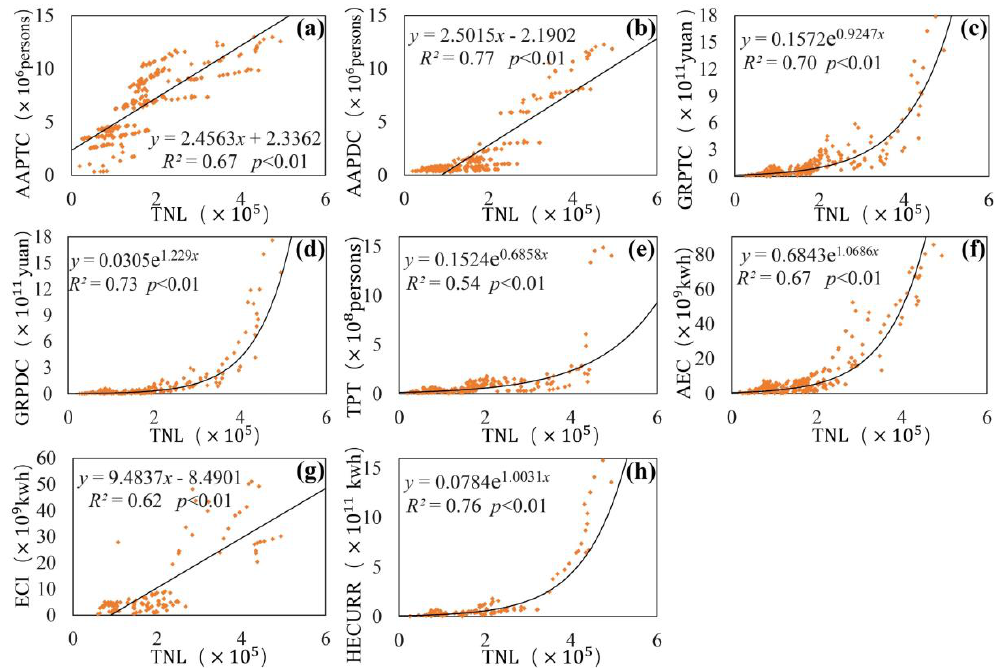
Figure 6. Regression analysis of di ff erent socioeconomic parameters and TNL. Population parameters: ( a ) AAPTC, ( b ) AAPDC; Economic parameters: ( c ) GRPTC, ( d ) GRPDC; Tra ffi c parameters: ( e ) TPT; Energy parameters: ( f ) AEC, ( g ) ECI, ( h ) HECURR.